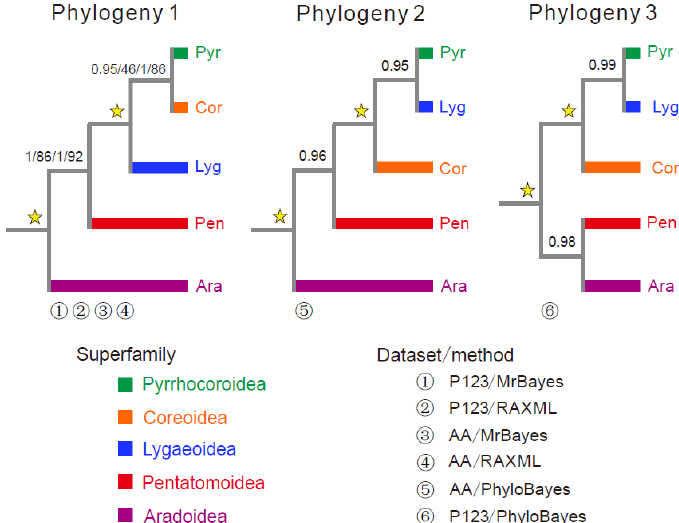
Figure 5. Phylogenetic relationships constructed by three phylogenetic methods (RAXML, MrBayes, and PhyloBayes) among five Pentatomomorpha super-families. Phylogenetic analyses are based on the concatenated nucleotide (P123) and amino acid (AA) sequences of 13 protein-coding genes. Numbers on branches are bootstrap values and Bayesian posterior probabilities. Numbers 1–6 indicate phylogenetic relationships among the five super-families obtained with different mitogenomic datasets and analytical methods. Table 2. Topology test